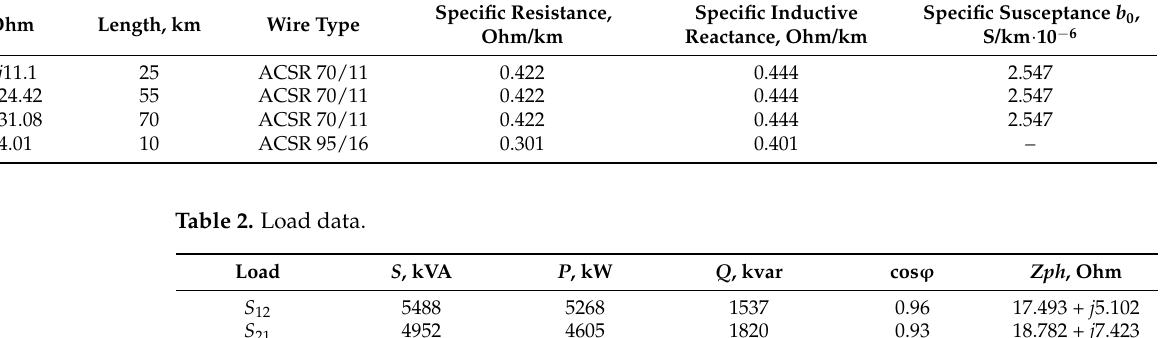
Table 1. Power transmission lines data.